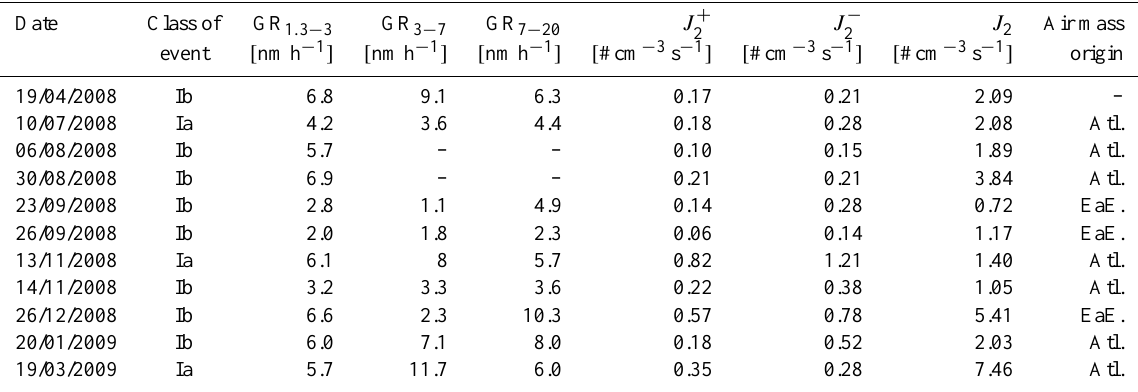
Table A1. Details of nucleation characteristics. Atl. is for Atlantic and EaE. for Eastern